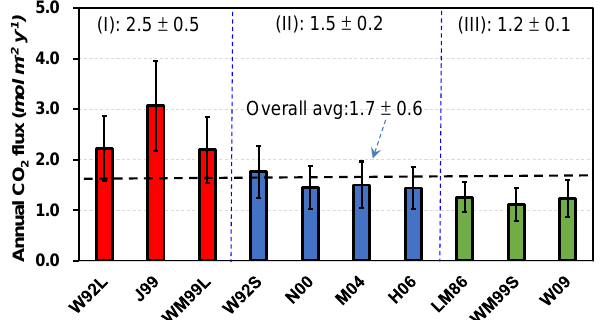
Figure 11. Comparison among the averaged annual CO 2 fluxes esti- mated by different algorithms in the study period. Three distinctive groups: (I) highest average: − 2.5 ± 0.5molCm − 2 yr − 1 ; (II) mid- range: − 1.5 ± 0.2; (III) low values: − 1.2 ± 0.1 with an overall av- erage: − 1.7 ±